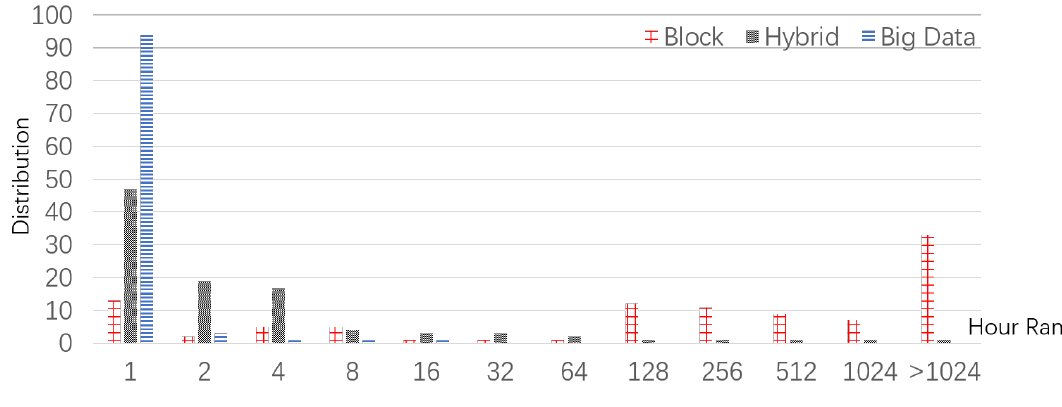
Figure 3. Distribution of workload